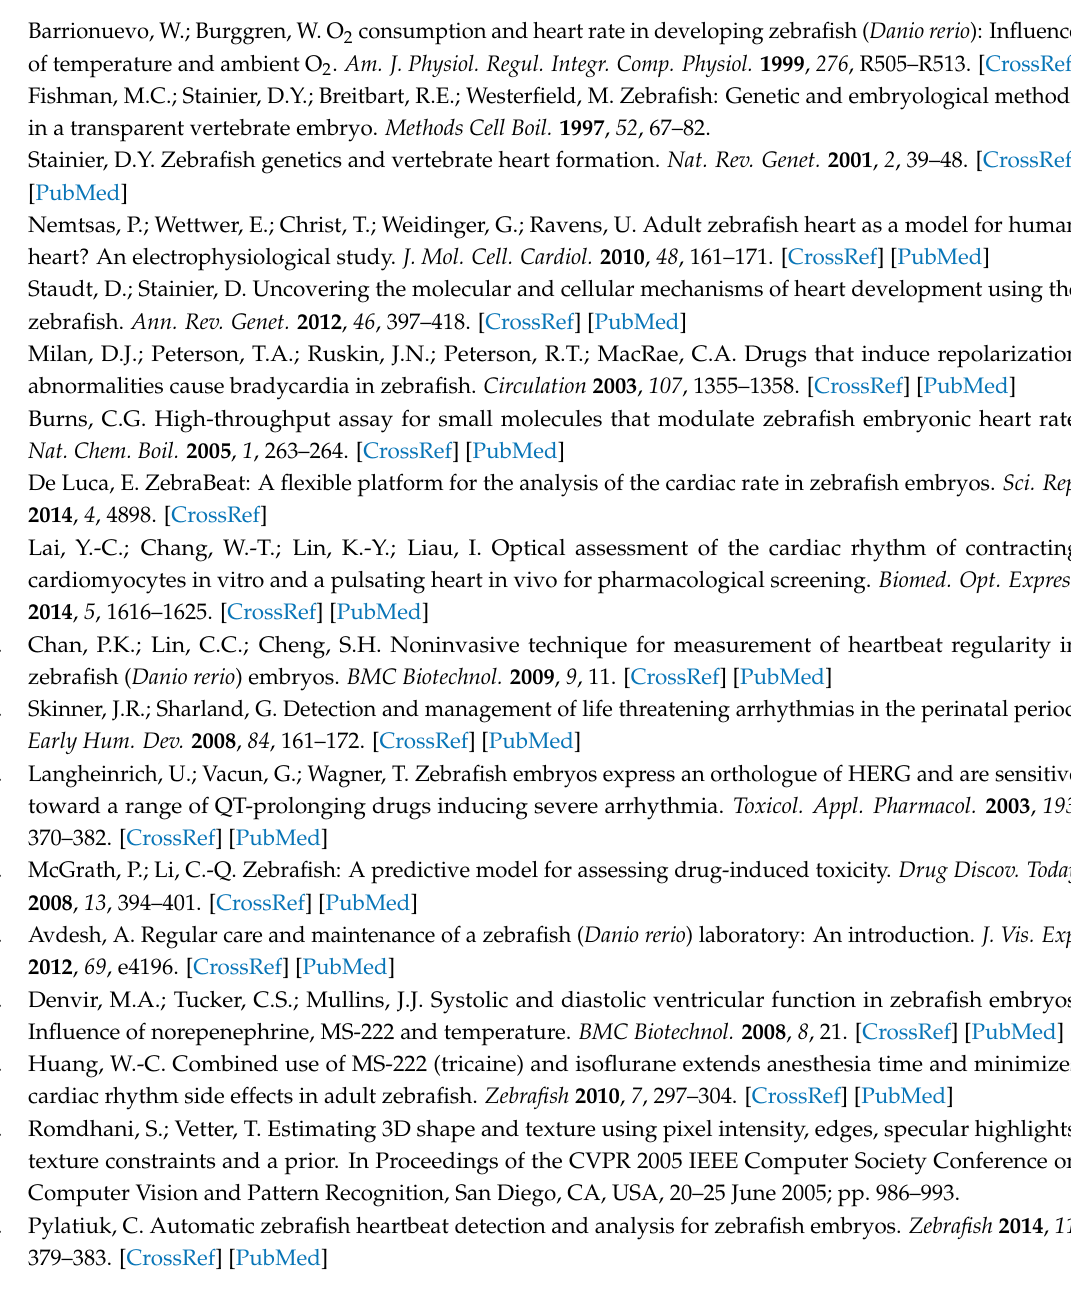
Figure S1: The schematic picture showing the movement of fish during video recording will cause dynamic pixel alteration, but still can extract the heartbeat frequency from the recorded videos, Video S1: The heartbeat in wild-type zebrafish embryos aged at 72 hpf, Video S2: The heartbeat in astemizole-treated zebrafish embryos aged at 72